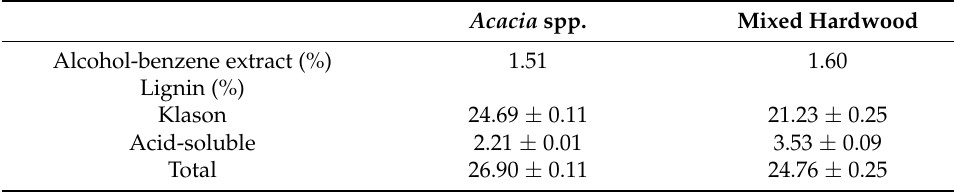
Table 1. Chemical composition of wood meals used in MWL preparation. Acacia spp. Mixed Hardwood